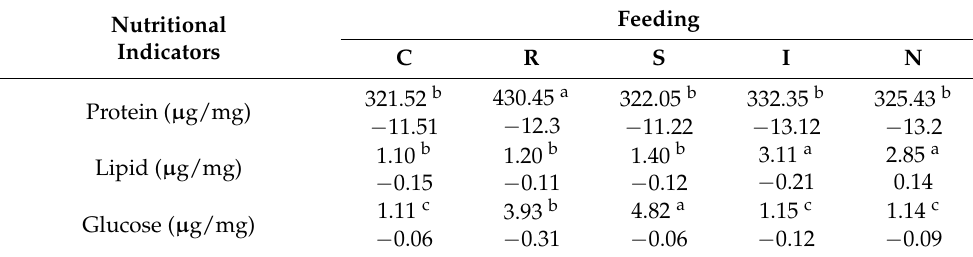
Table 3. Body composition of corals 1 h after being fed different aquaculture feeds. Nutritional